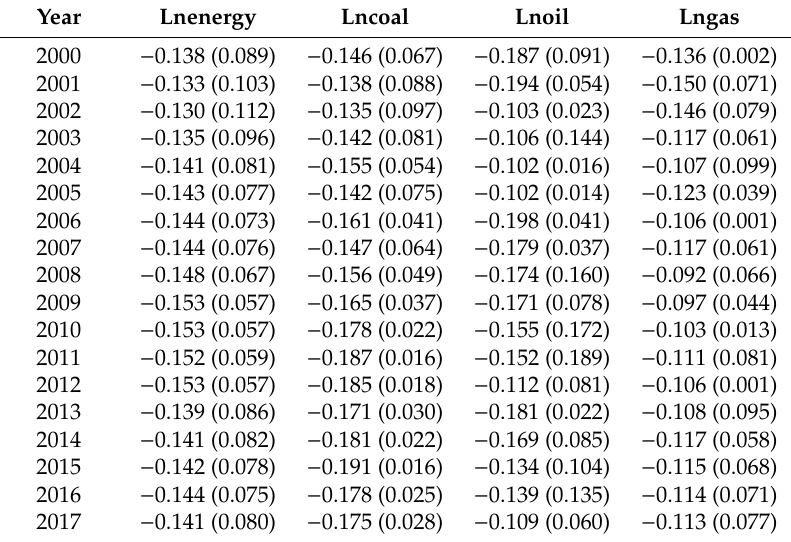
Table 3. Spatial autocorrelation test global Moran